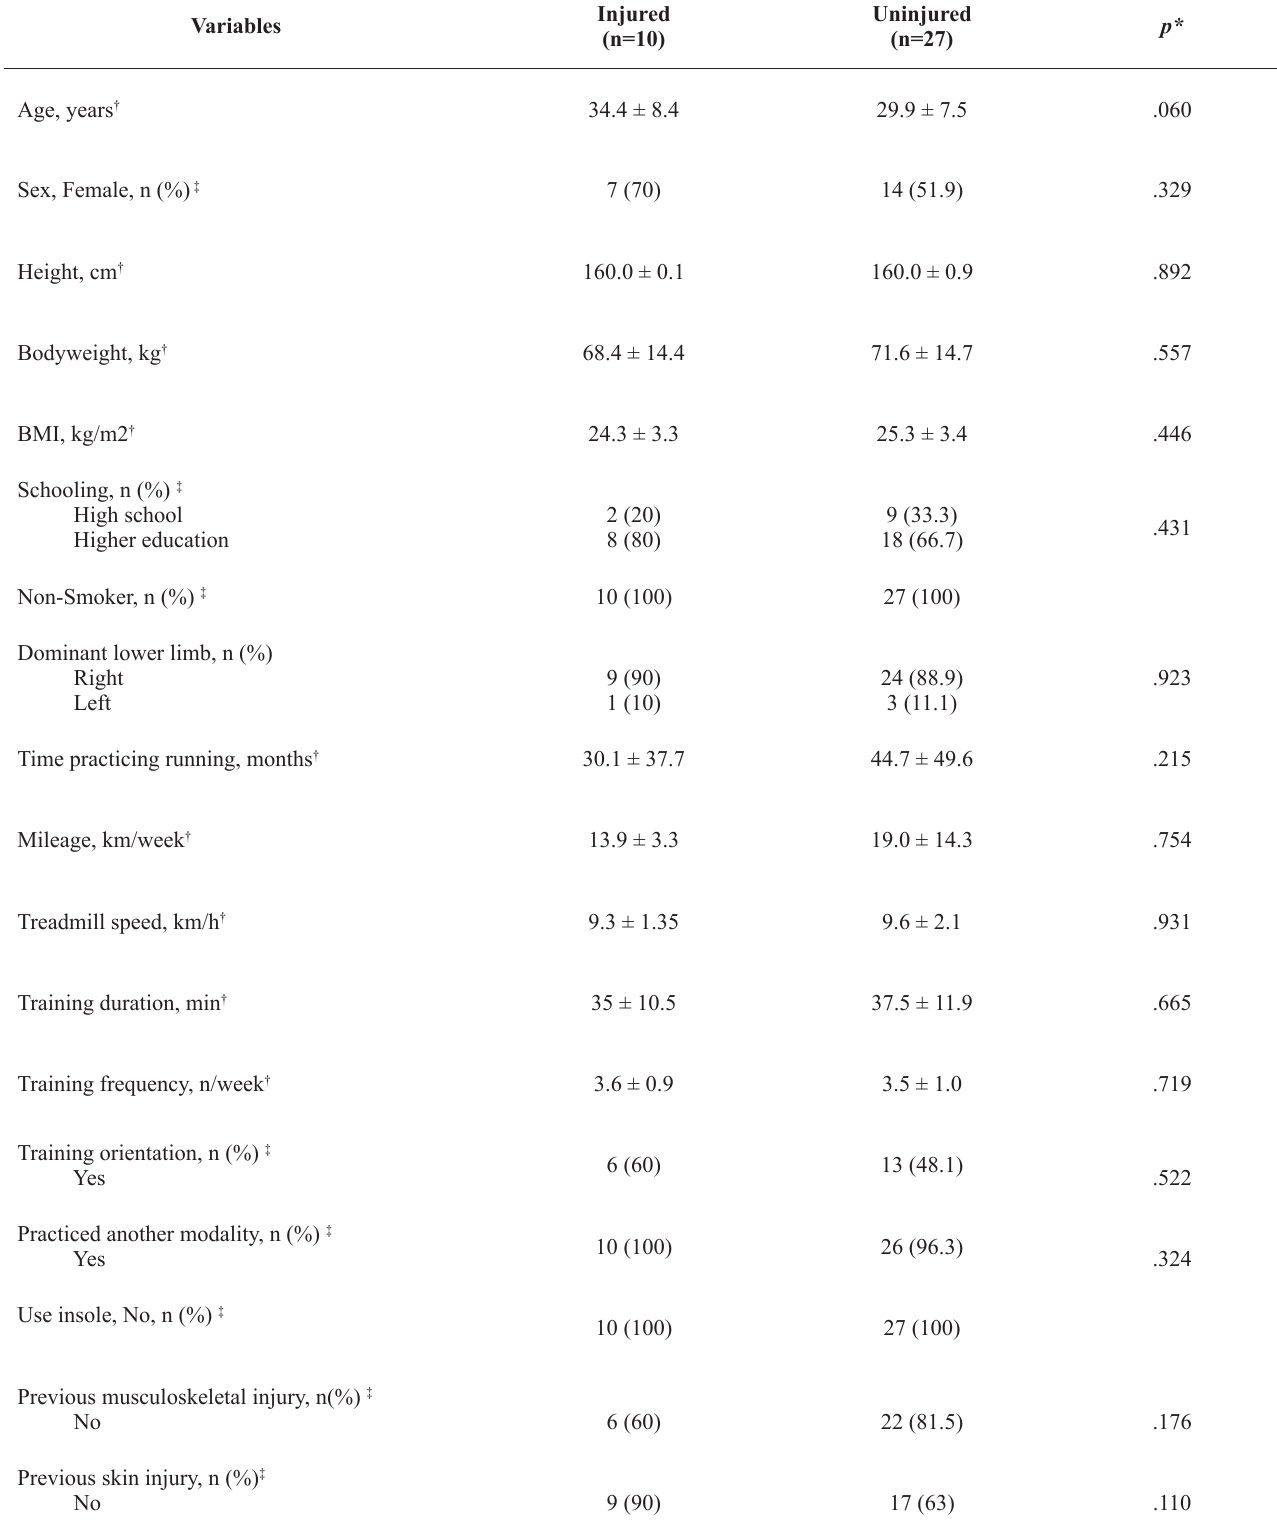
Table 1 - Baseline characteristics of treadmill